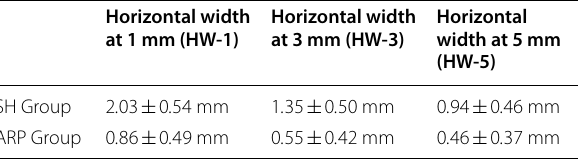
Table 1 Horizontal width change 6 months after extraction